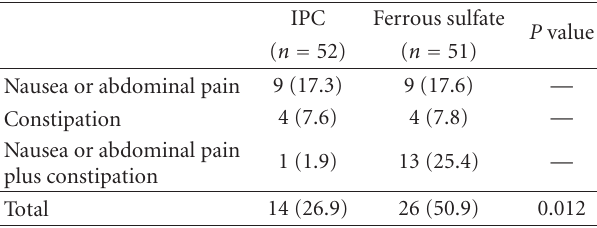
Table 3: Adverse events in pediatric patients with iron deficiency anemia receiving oral iron therapy with iron hydroxide polymaltose complex (IPC) or ferrous sulfate, n